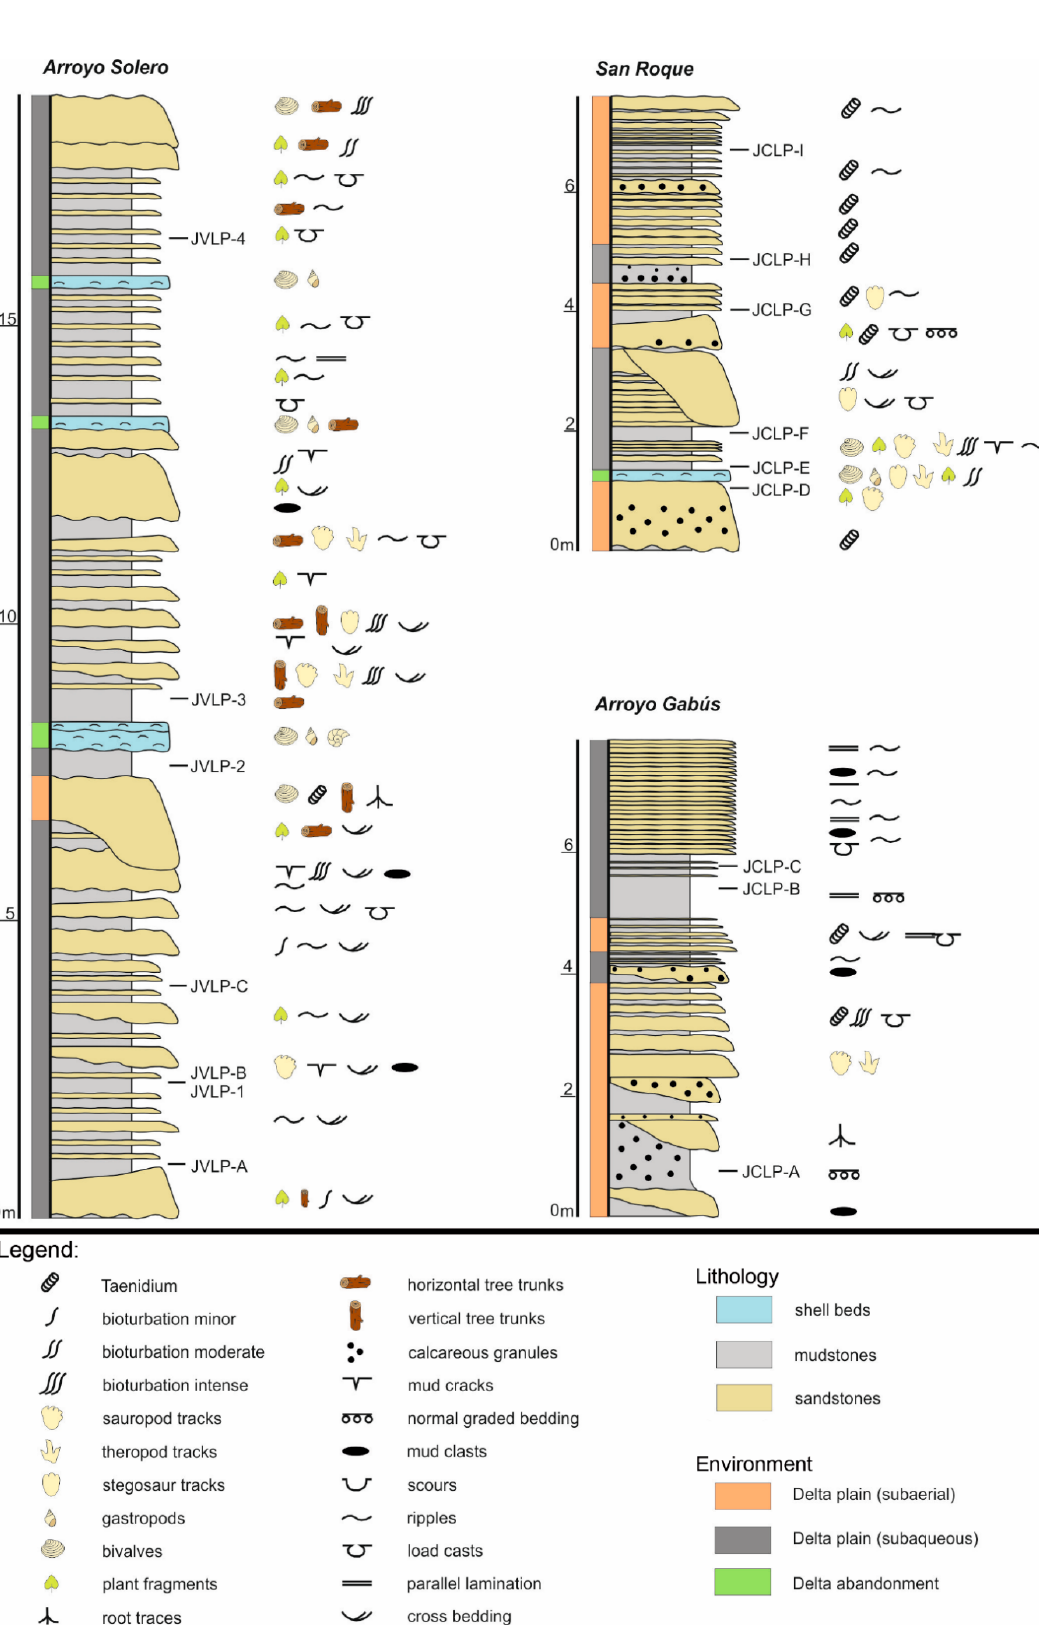
Figure 3. Stratigraphic sections of the Lastres Formation indicating the locations of the samples.